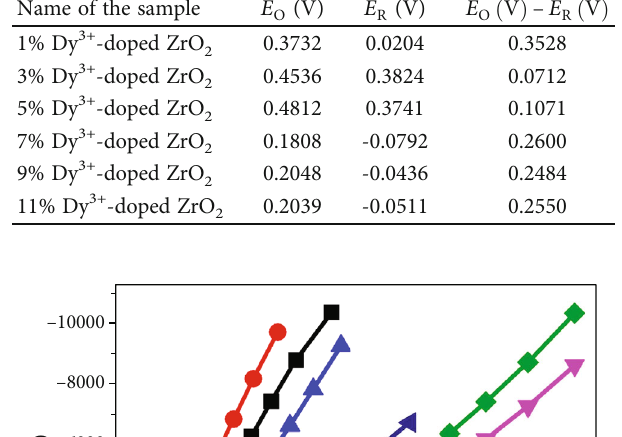
Table 4: Oxidation potential ( E di ff erence between E O and E R , di ff usion coe ffi cient of Dy 3+ -doped (1 – 11mol%) electrodes. ZrO 2